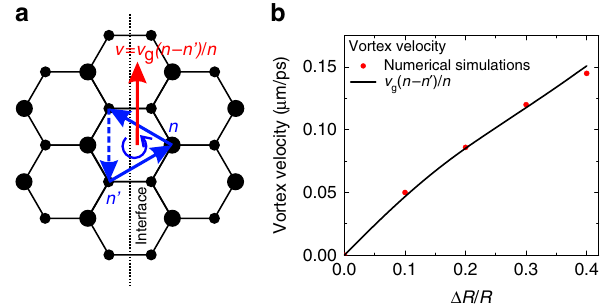
Fig. 4 Quantum vortex velocity. a A vortex at an interface and its net velocity. b Vortex velocity as a function of the gap size. Red points —